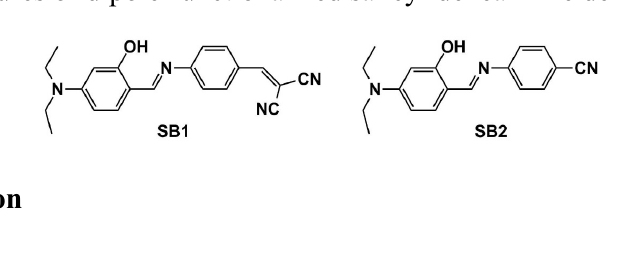
Figure 2. The structures of dipole-functionalized salicylideneaniline derivatives SB1 and SB2